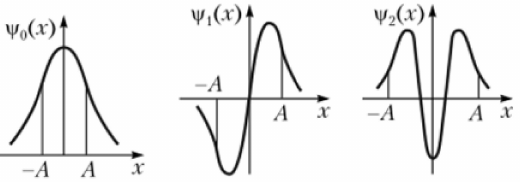
Figure 7. Wave functions of the harmonic oscillator. Vertical dashed lines indicate the turning points of the classical